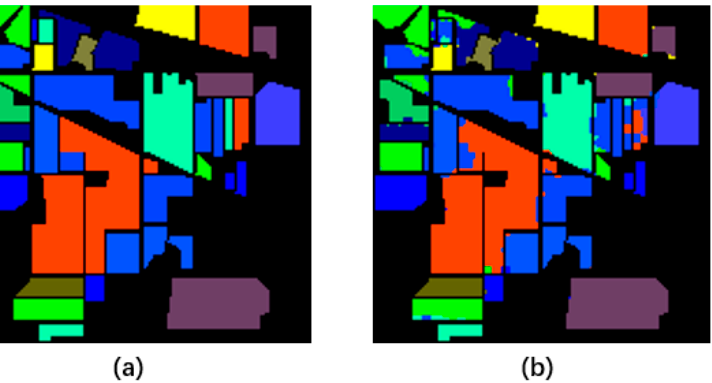
Figure 29. The classification result of our model. ( a ) is the ground truth; ( b ) is the classification result of our model.